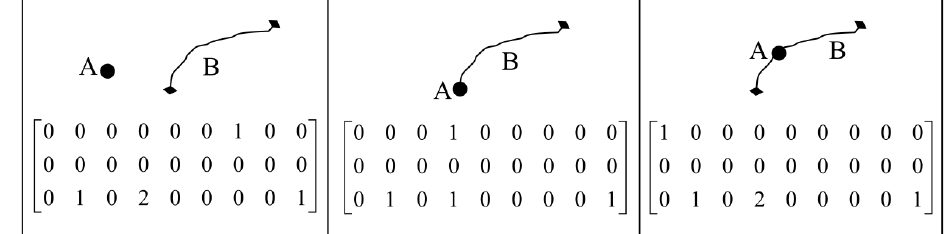
Figure 4. The formalism of the 27IM and the corresponding geometric interpretations between a point and a line.